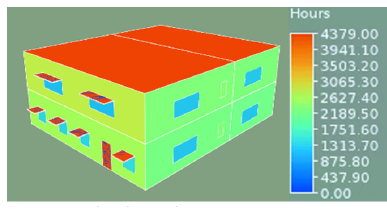
Figure 7. Shading devices arrangement.